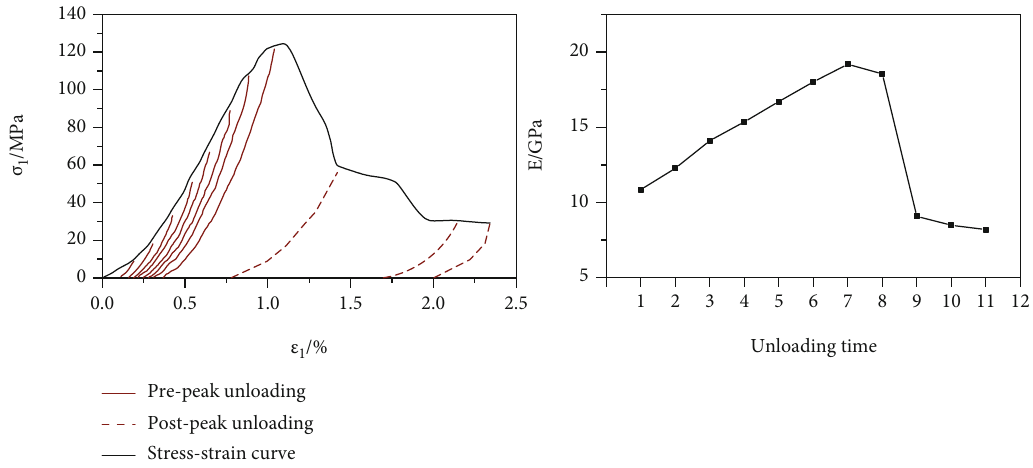
Figure 4: Unloading curves and evolution of elastic modulus under 5MPa con fi ning pressure.